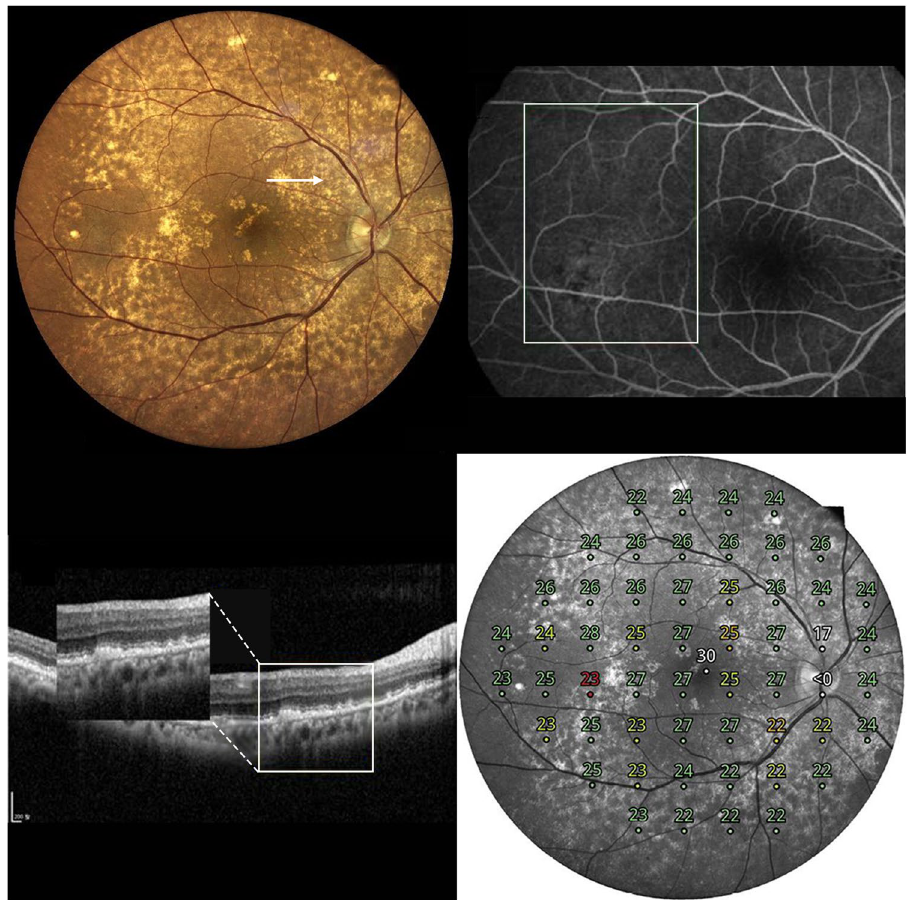
Figure 4. A representative case of type 3 cuticular drusen. A 66-year-old man presented with type 3 cuticular drusen. ( A ) Color fundus photography showed numerous cuticular drusen. The cuticular drusen area was scanned using spectralis-domain optical coherence tomography (SD-OCT) (arrow). ( B ) Fundus fluorescein angiography showing hyperfluorescent drusen. This can confirm the diagnosis of cuticular drusen. ( C ) In the SD-OCT image scanned on the site of the arrow in Photo ( A ), the cuticular drusen area is magnified to categorize the types of cuticular drusen. It can be diagnosed as a type 3 cuticular drusen in which broad, mound-like elevation of the retinal pigment epithyelim is present in a spectralis domain optical coherence tomography image. ( D ) Retinal sensitivity using microperimetry is topographically presented in a composited image.